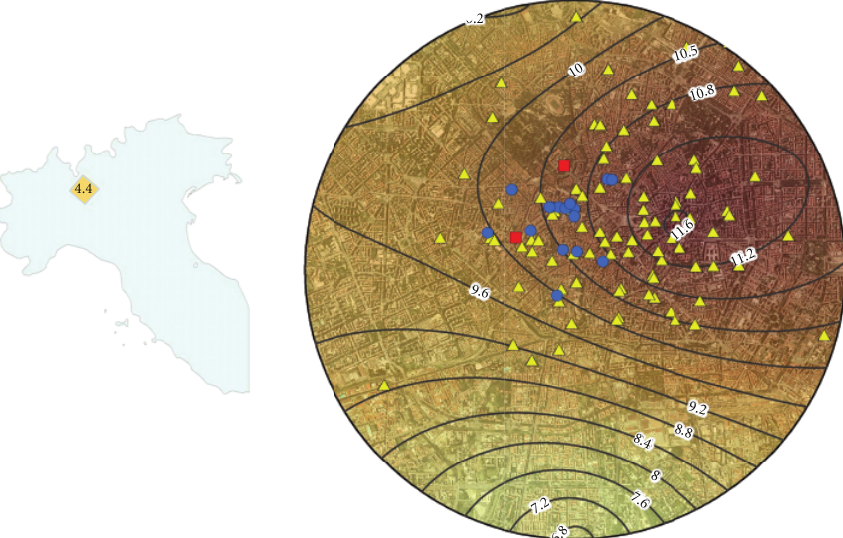
Figure 11: Calculated surface recession of limestone in µ m (one-year exposure), based on the dose-response function for the SO 2 dominating situation, for the Milan city centre, reported either as one single value based on the EMEP 50km × 50km grid cell (left, 4.4 µ m) or as a map of the city centre based on local data (right, 6.8 to 11.6 µ m). Coloured symbols (blue, red, and yellow) in the map to the right indicate di ff erent types of cultural heritage